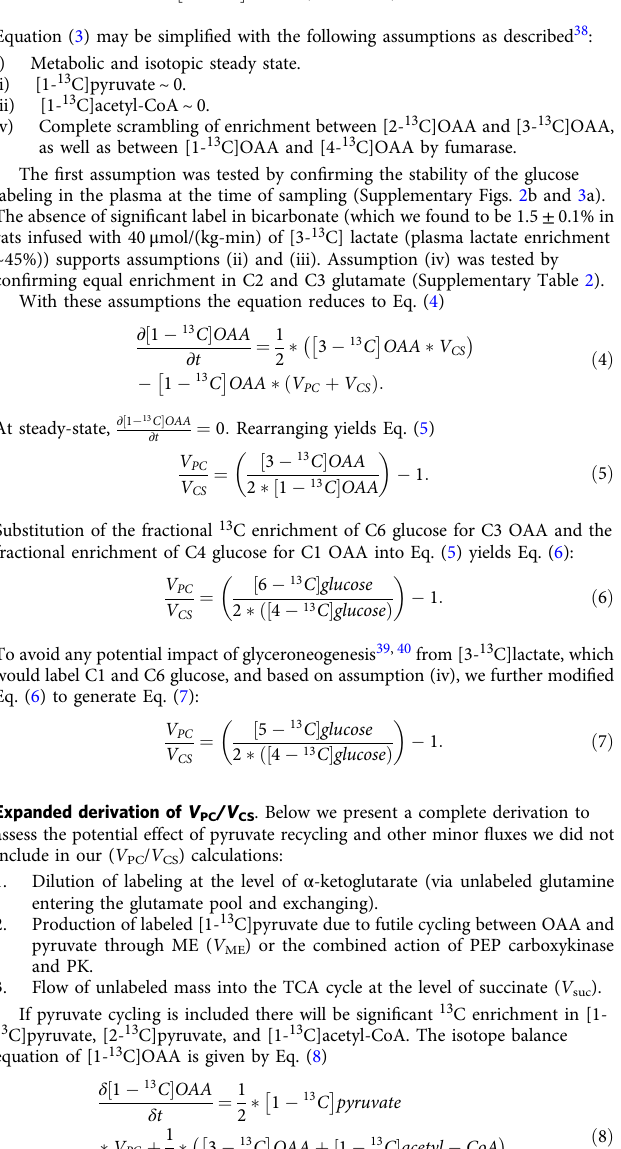
Table 2 Flux modeling ratios ( V PC / V EGP, Eq. (1), and V PC / V CS , Eq. (2)) used in the PINTA method Ratio